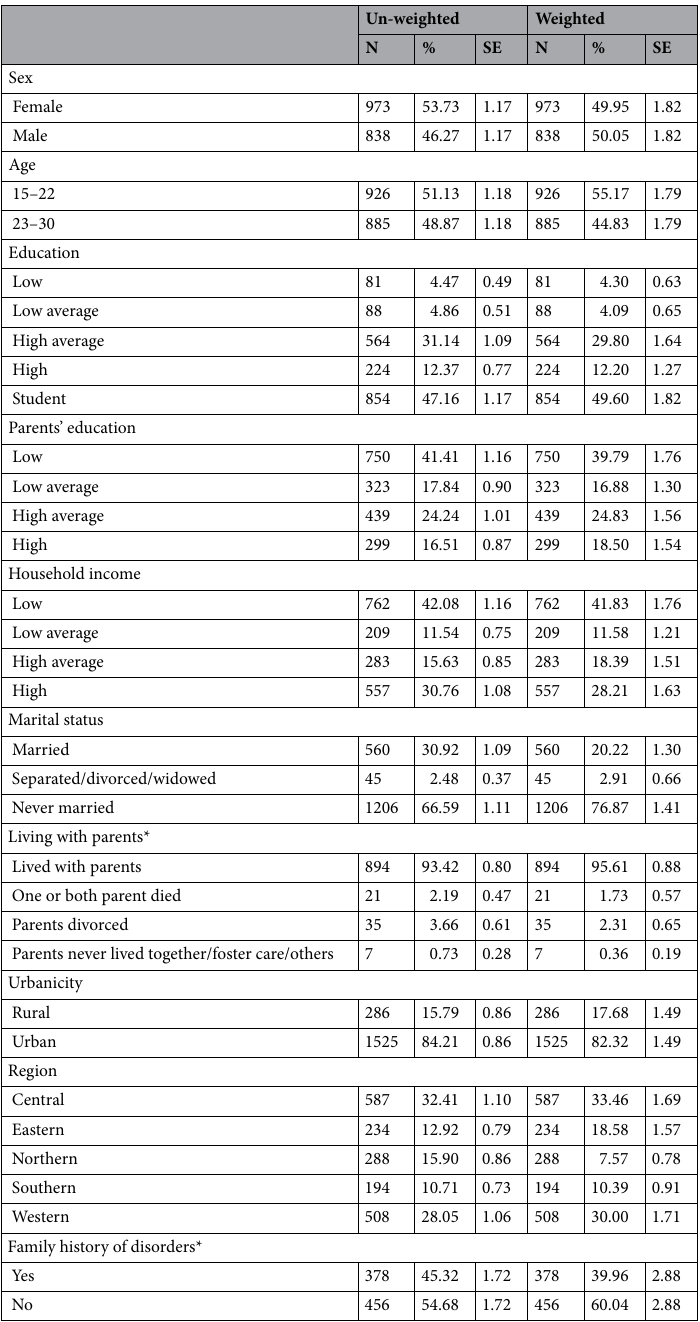
Table 1. Socio-demographic distribution of the youth sample, un-weighted and weighted. Part I sample was used (n = 1811); *This was asked to only part II sample (n = 971). Missing data: living with parents = 14; family history of disorders =